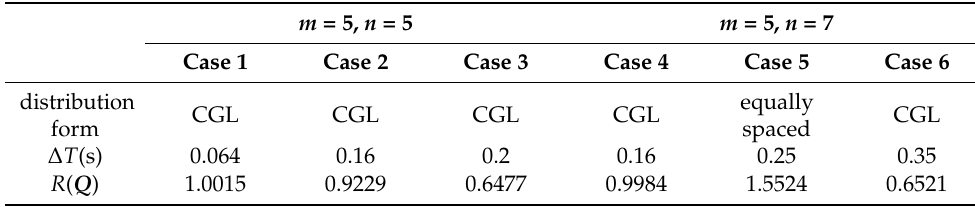
Table 1. R ( Q ) under different mesh forms and time steps.